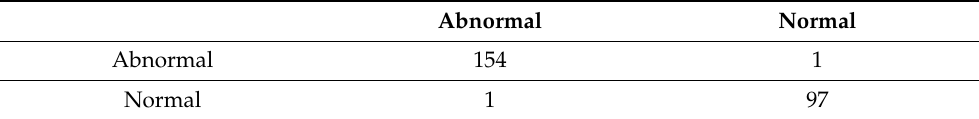
Table 2. Confusion matrix for the Kaggle dataset using the BTR method.